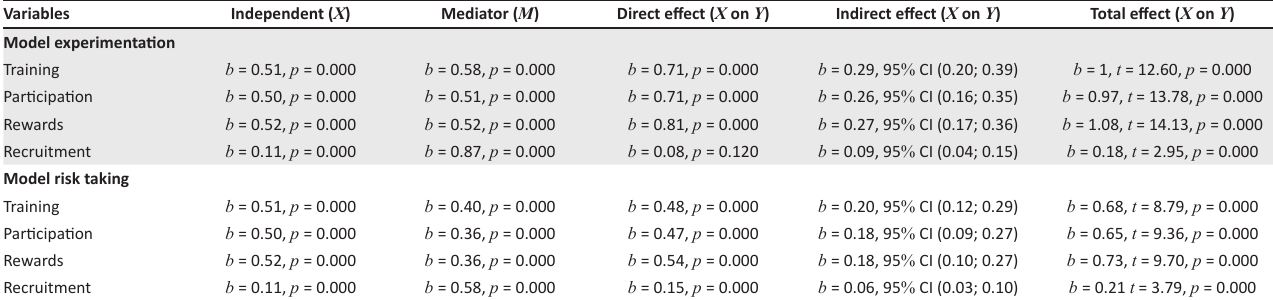
TABLE 6: Mediation analysis.